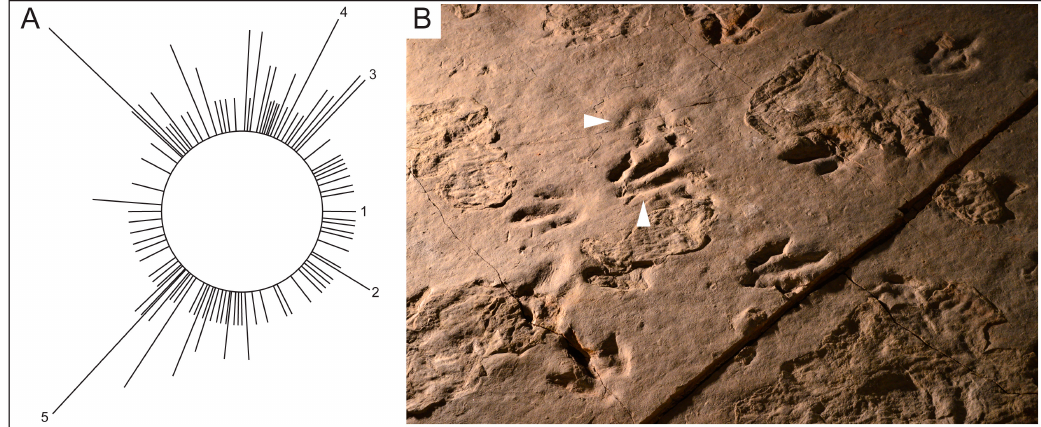
Figure 5. Eubrontes giganteus orientations and trackways from Dinosaur State Park in Rocky Hill, Connecticut. ( A ) Rose diagram of track and trackway orientations modified from [2] and used with permission of Elsevier; ( B ) Photograph of part of the in situ track surface showing random orientation and tracks of different depths. The horizontal arrowhead points to a shallow track with a diffuse outline, whereas the vertical arrowhead points to an adjacent deep track with very distinct margins.